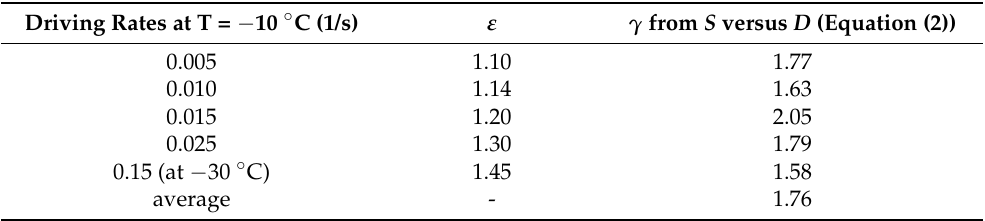
Table 2. Calculated exponents as the function of the driving rate at T = − 10 ◦ C. At each driving rate, three measurements were carried out and the results are the average for the three runs. Results . ε = 0.15 s − 1 at − 30 ◦ C are also included for obtained at